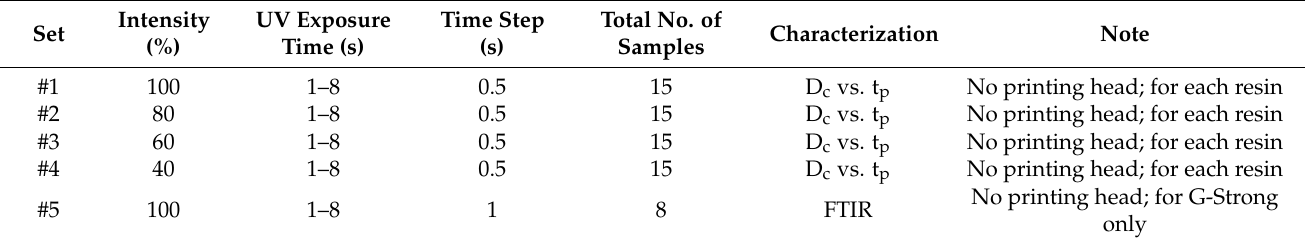
Table 1. Details of five sets of prepared samples (i.e., monolayer films, using the “no printing head” configuration; see text for details). In sets #1–#4, samples were produced for each resin, modulating the radiation intensity; in set #5, G-Strong samples were prepared for FTIR